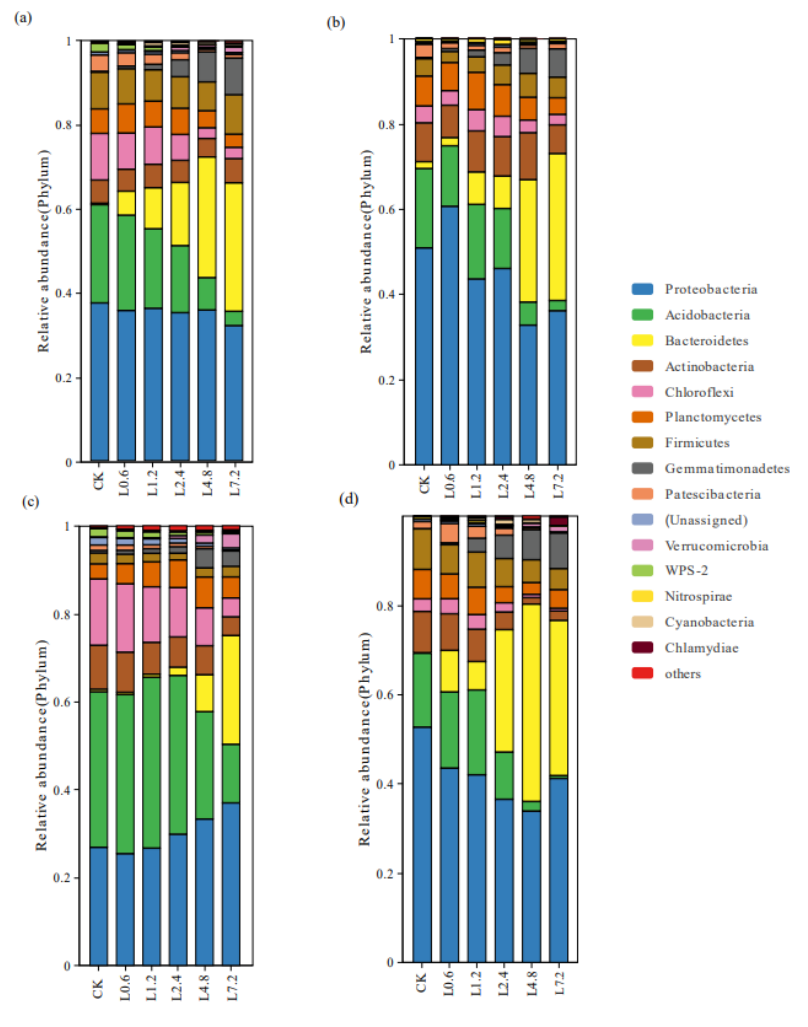
Figure 6. Composition of four soil bacterial communities under different lime dosage treatments. The letters ( a – d ) represent soil types.